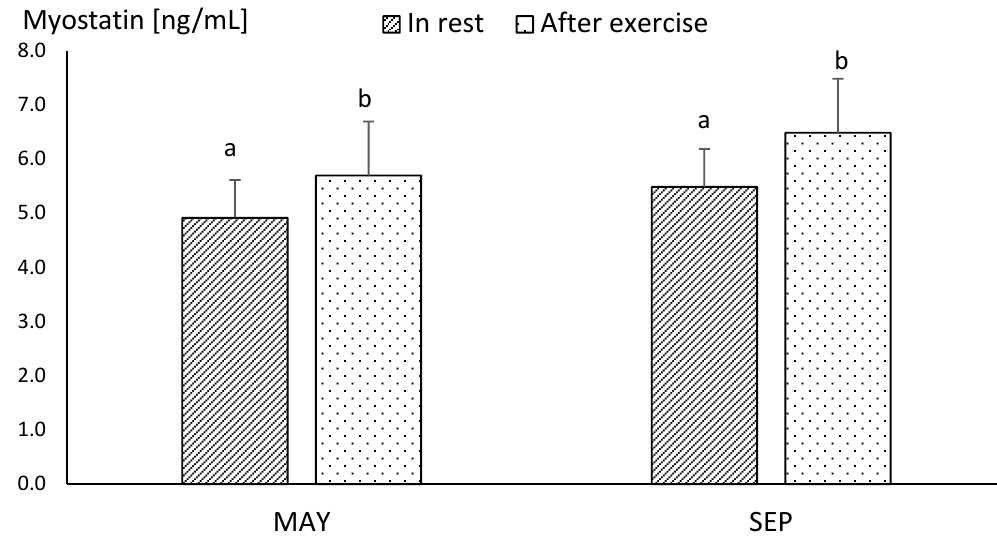
Figure 3. The mean values of plasma myostatin concentration in racehorse at the beginning (MAY) and in the end (SEP) of the training season. Error bars represent standard errors ( n = 10). a,b—different letters indicate significant differences ( p ≤ 0.05).